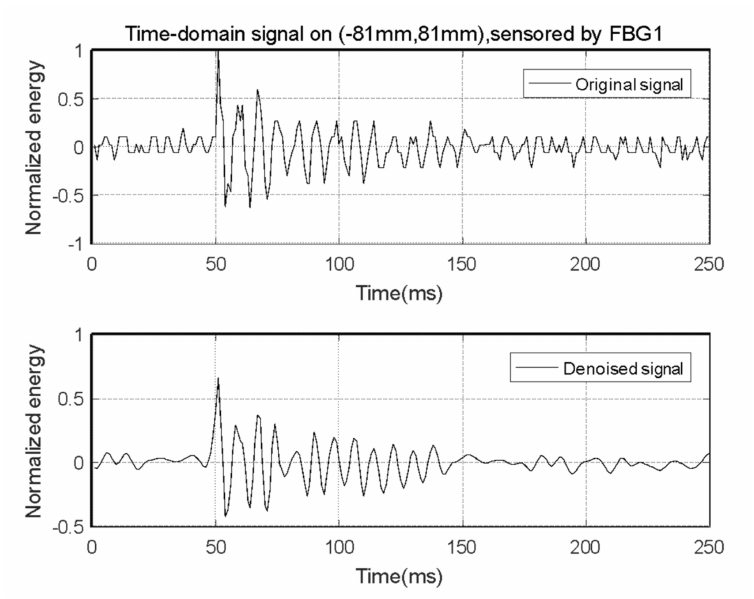
Figure 10. Wavelet noise-reduction effect of time-domain impact response signal.